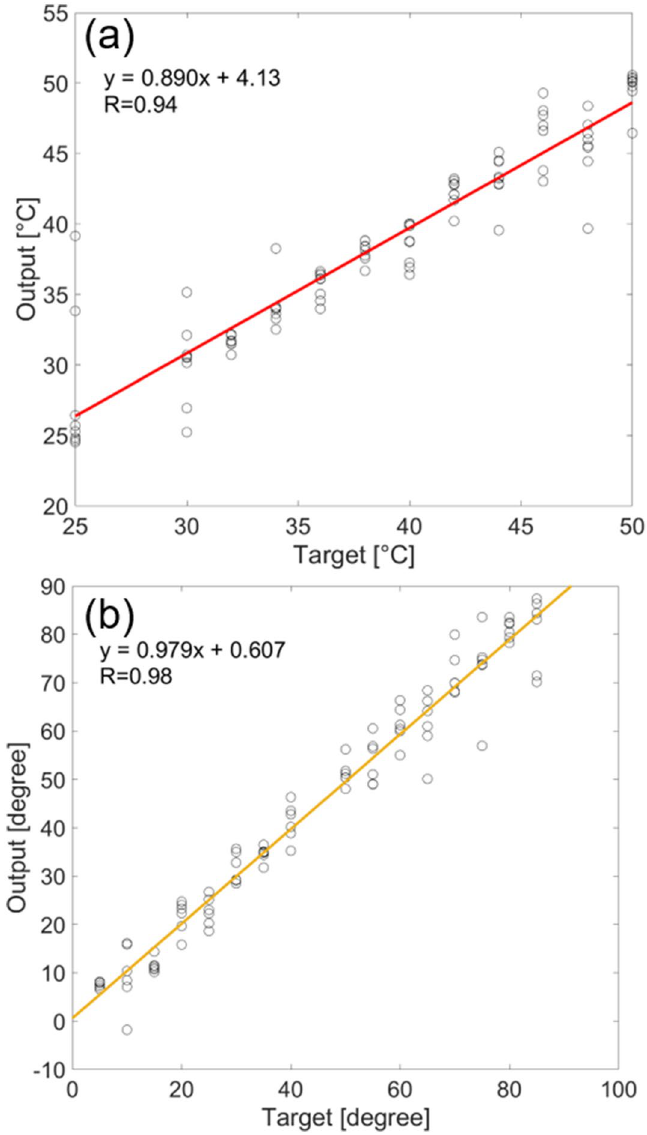
Figure 2. The neural network response fittings for the training data of the temperature (a) and the orientation angle, (b) . The target values correspond to the experimental conditions of the angles and the temperatures. The correlation coefficients, R, are shown for